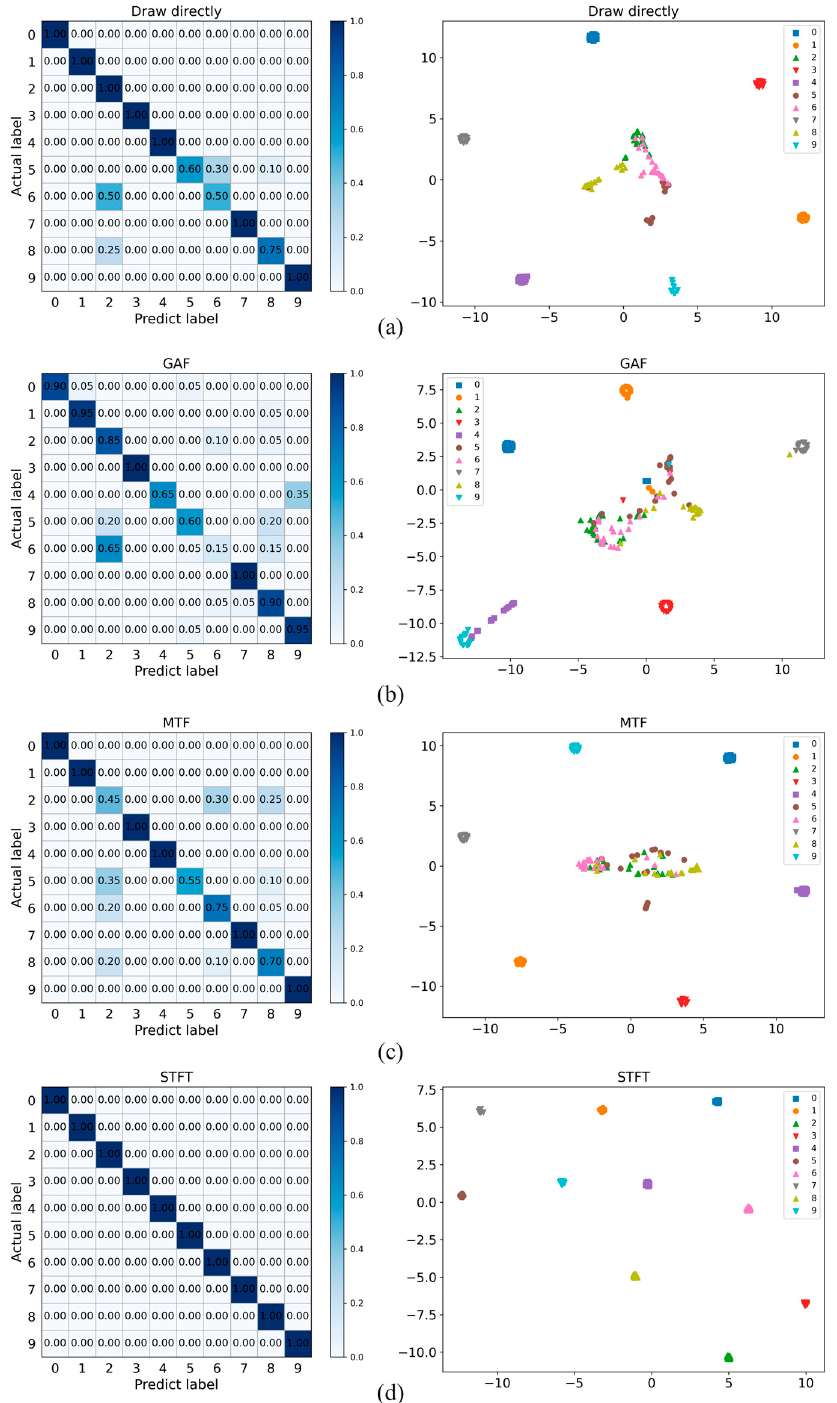
Figure 13. Confusion matrix and cluster analysis results of four methods: ( a ) draw directly, ( b ) GAF, ( c ) MTF, ( d ) STFT. ( c ) MTF, ( d )